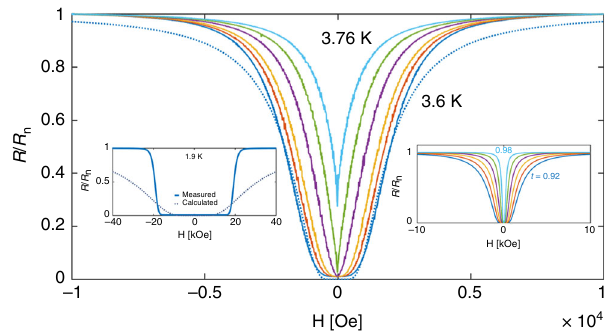
Fig. 5 Magnetoresistance of the Nb-coated superlattice as a function of the applied magnetic fi eld. R normalized to R n = 260 Ω vs. H at temperatures 3.6, 3.62, 6.64, 3.68, 3.72, and 3.76 K. The dotted line is a fi t to Equation (2) for T = 3.6 K. Inset: Calculated magnetoresistance based on Equation (2) for t = T / T c = 0.92